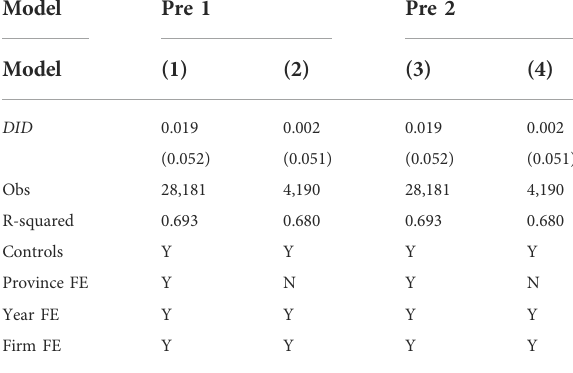
Ps: Robust standard errors in